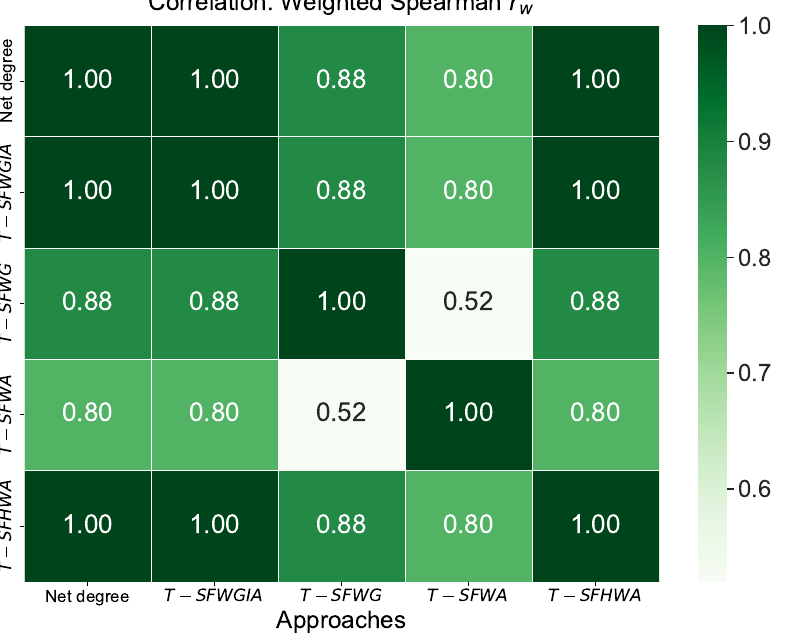
Figure 3. Heat map for the weighted Spearman correlation coefficient r w of the considered